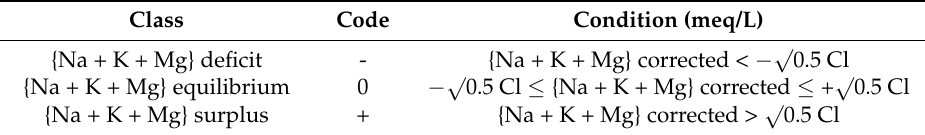
Table 5. Subdivision of subtypes into classes according to {Na + + K + + Mg 2+ } corrected for sea salt [65].